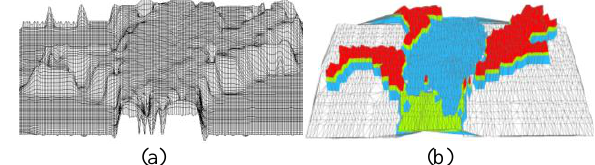
Figure 4 Test results based on multi-spectral canopy lidar:(a) the 3D reconstruction based on the measured cloud points and (b) an SVM classification results based on the spectral